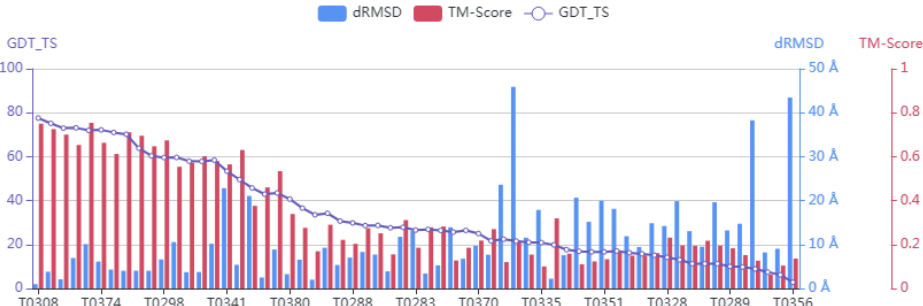
Figure 4. The mixed line and bar shows the comparison of dRMSD , TM-Score and GDT_TS . Its horizontal axis represents the id of the protein chain, and the vertical axis represents the value of the evaluation criterion. This comprehensively shows the prediction situation of the RGN, enriches the analysis angle, and provides a channel for interactive